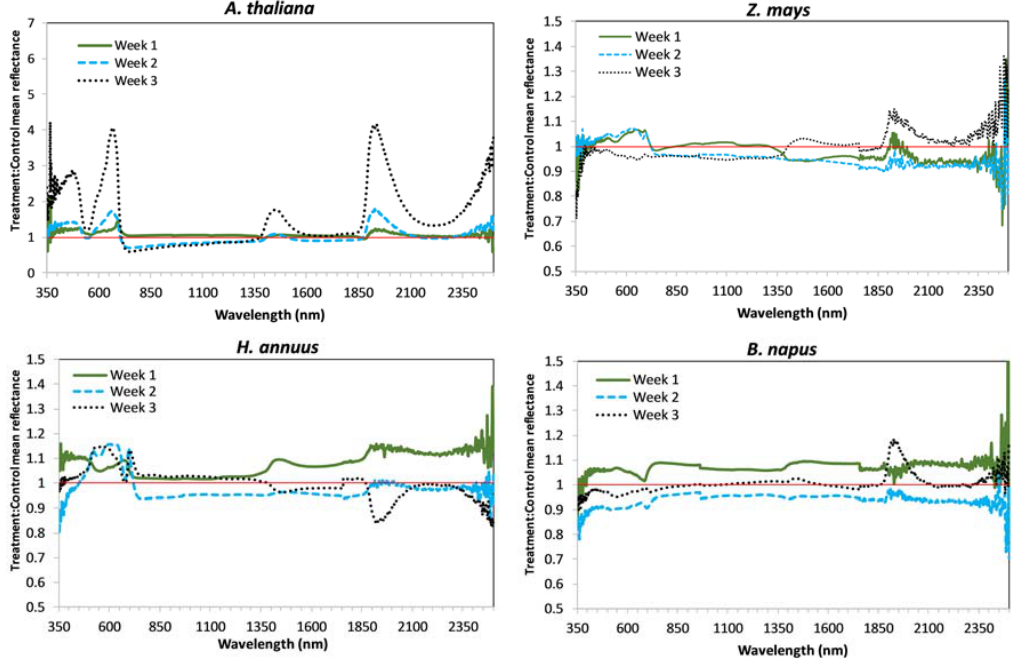
Figure 2. Relative reflectance of treatment to control for each of four species as acquired by FOV.